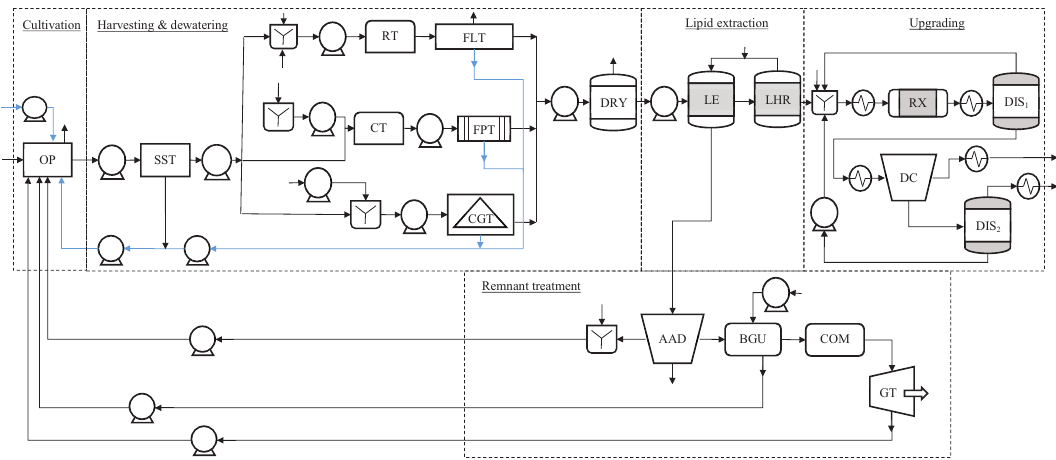
Figure 1. Process-flow diagram of an algal biorefinery with five processing sections. Main unit operations are open pond (OP), retention tank (RT), settling tank (SST), conditioning tank (CT), centrifugation technology (CGT), floatation technology (FLT), filter-press technology (FPT), dryer (DRY), lipid extraction (LE), lipid-hexane separation (LHR), biogas upgrading (BGU), anaerobic digester (AAD), combustion (COM), gas turbine (GT), transesterification reactor (RX), distillation column (DIS), and decanter